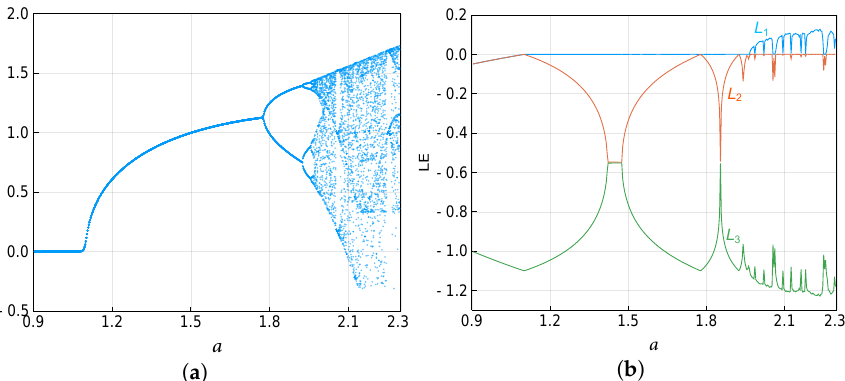
Figure 2. ( a ) Bifurcation diagram, and ( b ) Lyapunov exponents spectrum versus a of system (16). For a = 2, α = 0.3, system (16) becomes